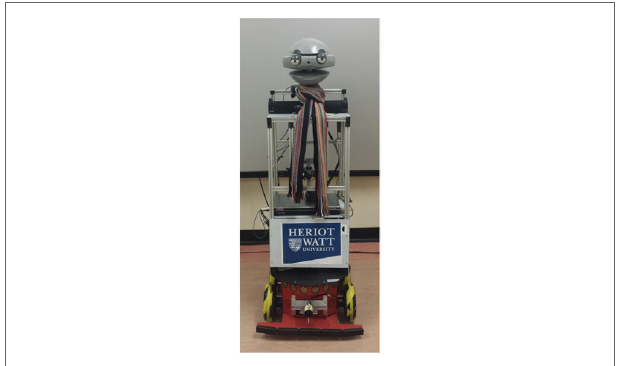
FigUre 1 | “Team Buddy” (TB), office companion, height 1.2 m.